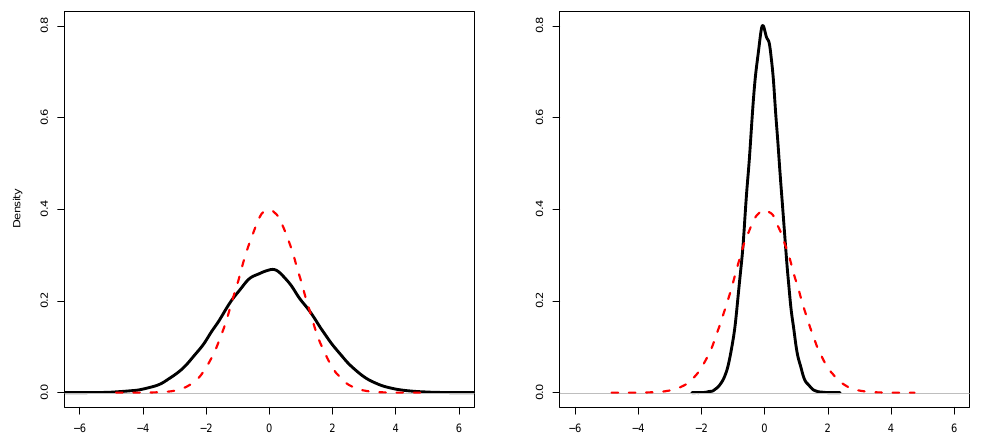
Figure A1. Probability density function of S P under the null hypothesis ( α = 0, solid black line) against the N ( 0,1 ) (red dashed line): ( left panel ) moderate overdispersion ( ε t ∼ NB ( 10,0.5 ) ); ( right panel ) moderate underdispersion ( ε t ∼ Bin ( 2,0.5 )